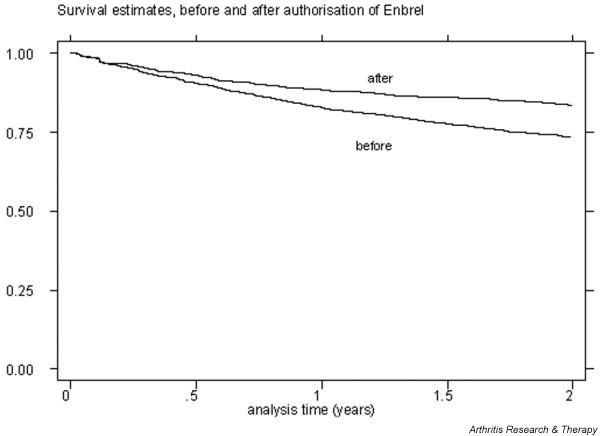
Survival estimates of infliximab before and after the marketing authorization of etanercept (p < 0.001).